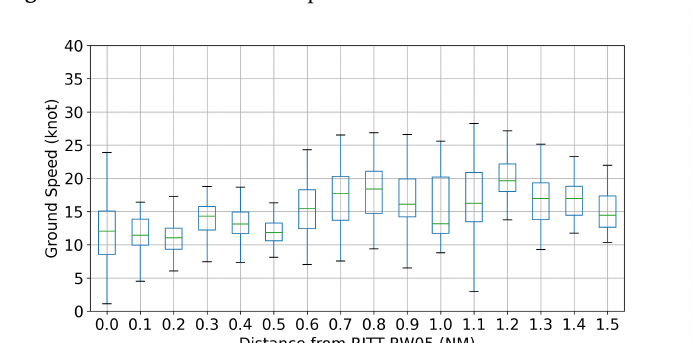
Figure 5. GS distribution of departures from T2.